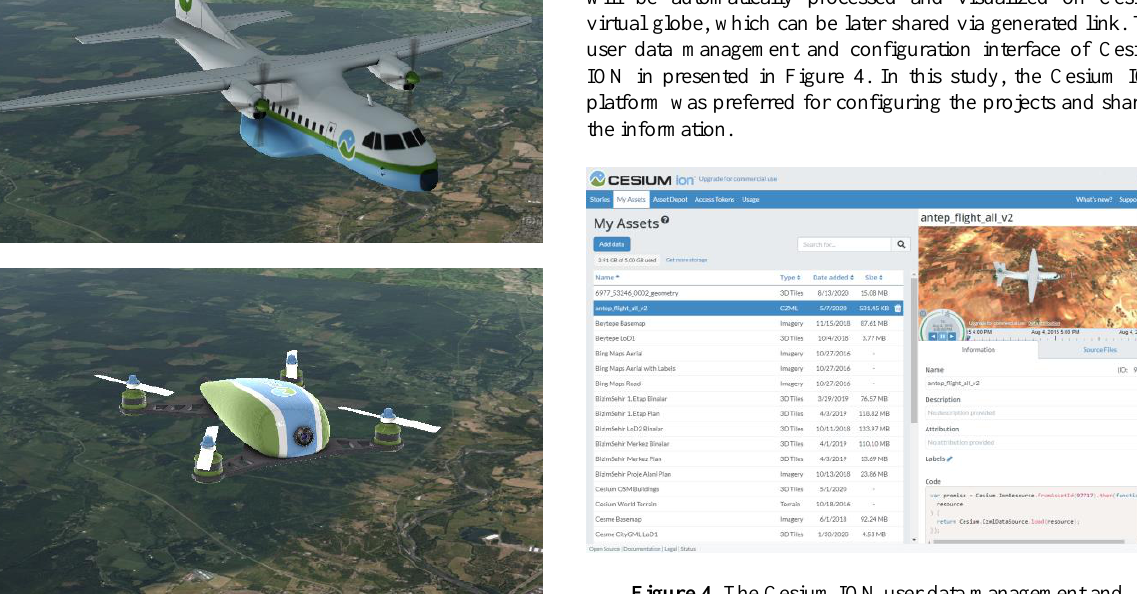
Figure 4 . The Cesium ION user data management and configuration